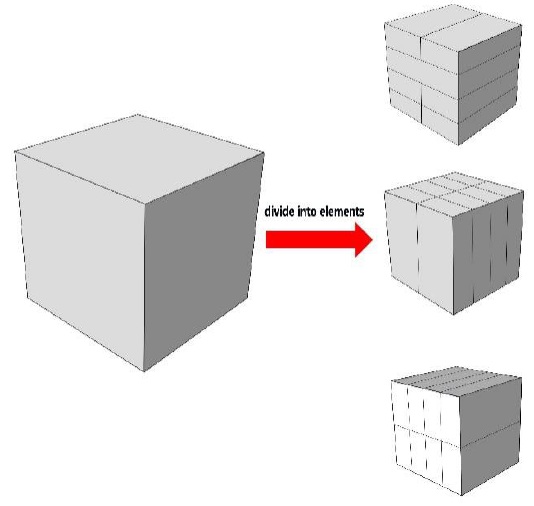
Figure 11. Geometric division of axial compression specimens.